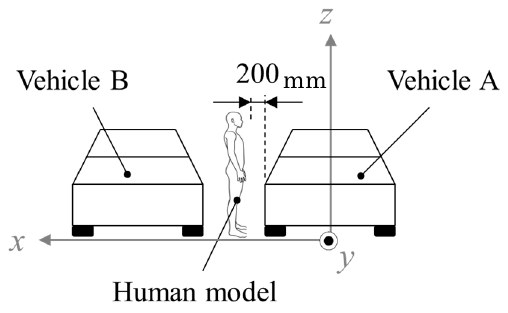
Figure 3. Positional relation between the human model and vehicles A and B.